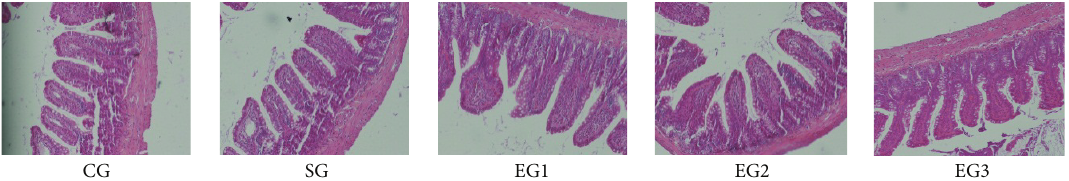
Figure 3: Histopathologic changes in the tissue of ileum using H&E staining and microscopy ( × 100). CG = control group; SG = sham group; EG1 = exposure group with peritoneal air exposure for 1h; EG2 = exposure group with peritoneal air exposure for 2 h; EG3 = exposure group with peritoneal air exposure for 3 h.